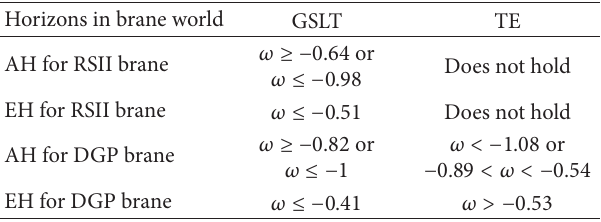
Table 1: Conditions for GSLT and TE to hold when Universe is filled with perfect fluid having constant equation of